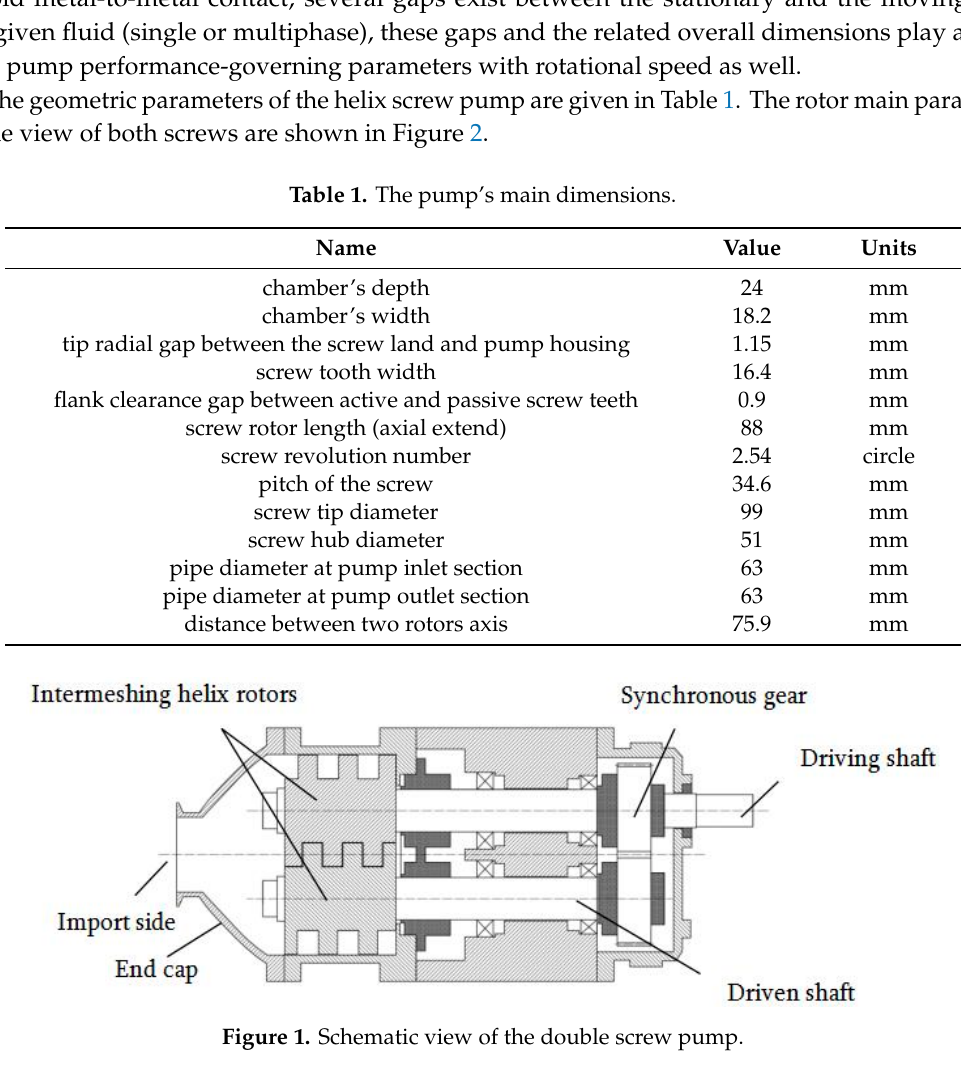
Figure 2. Screw pump rotor main parameters and the view of both screws (right side photography). See also Table 1. 3. Numerical Simulation Method 3.1. Immersed Solid Method Since the working chamber volume domain is continuously modified according to each step rotor position, numerical calculation uses an immersed solid technique. An immersed solid method is a dynamic mesh method, proposed in the ANSYS CFX software, which can perform steady state or unsteady simulation with rigid solid objects immersed in the fluid field. The simulation method is mainly applied to the simulation of moving boundary problems that are difficult to solve by other methods (such as for gear pumps, screw pumps and other grids with minimal mesh movement problems). During the simulation, the CFX solver applies a momentum source to the fluid in the immersed solids area to force the fluid to move with the solids. Immersed solids are considered as source terms in the flow equation that drives fluid motion to match solid motion. In order to solve the shape of the interface immersed in solid, immersed solid surface mesh quality requirements should be relatively high, as shown by Song et al. [14,15]. 3.2. Control Equations and Turbulence Model The flow inside the double helix pump depends on the mean flow rate, the screws' relative positions versus time and the interaction between screw rotation and the pump boundary walls. In this paper, the Reynolds time-averaged method is used to simulate the control equations of pump internal flow with a continuous equation, a three-dimensional Reynolds averaged N-S equation and a standard k- ε double equation assuming turbulent flow as performed by Song et al. [15]. For some specific working points, the k-omega SST model is also used for comparison purposes. The laminar model is ( a ) Dimensions illustration